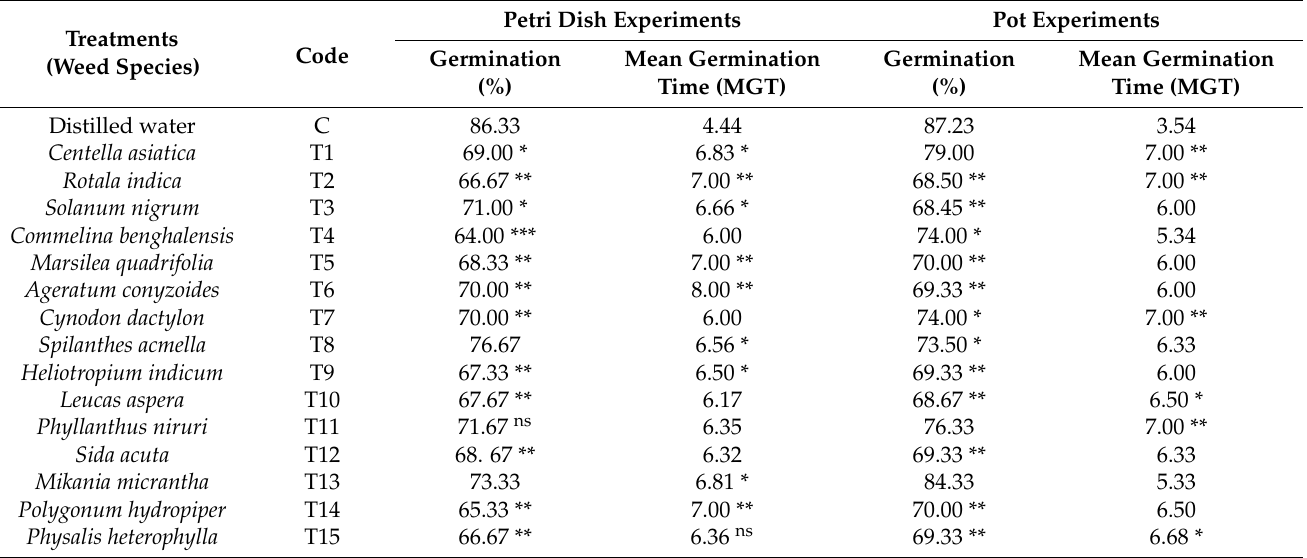
Table 3. Effect of aqueous root exudates of weed species on the germination of Triticum aestivum .